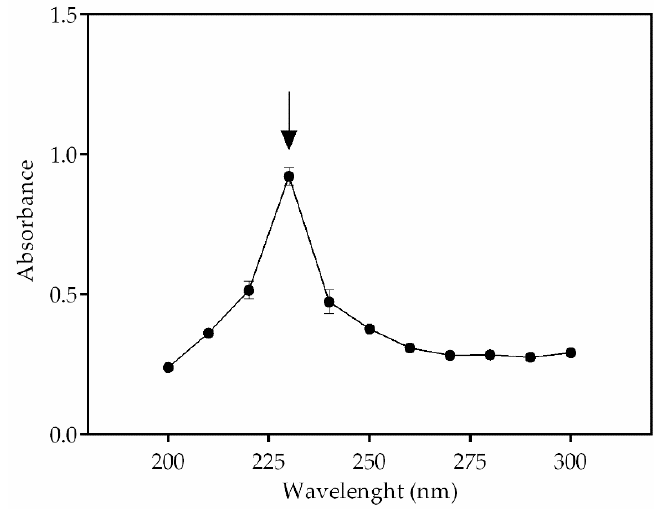
Figure 7. Occurrence of PHB in Stigeoclonium sp. B23 by absorbance spectrum. The black arrow indicates the wavelength between 225 and 235 nm, which confirms it as being PHB. Data are the mean ± SD of three replicates.